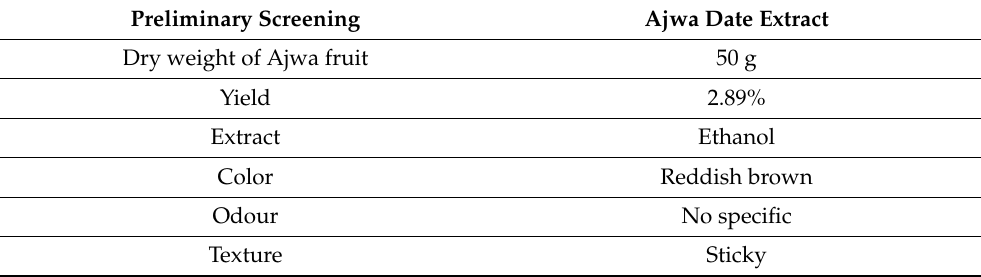
Table 2. Preliminary screening of Ajwa extract.